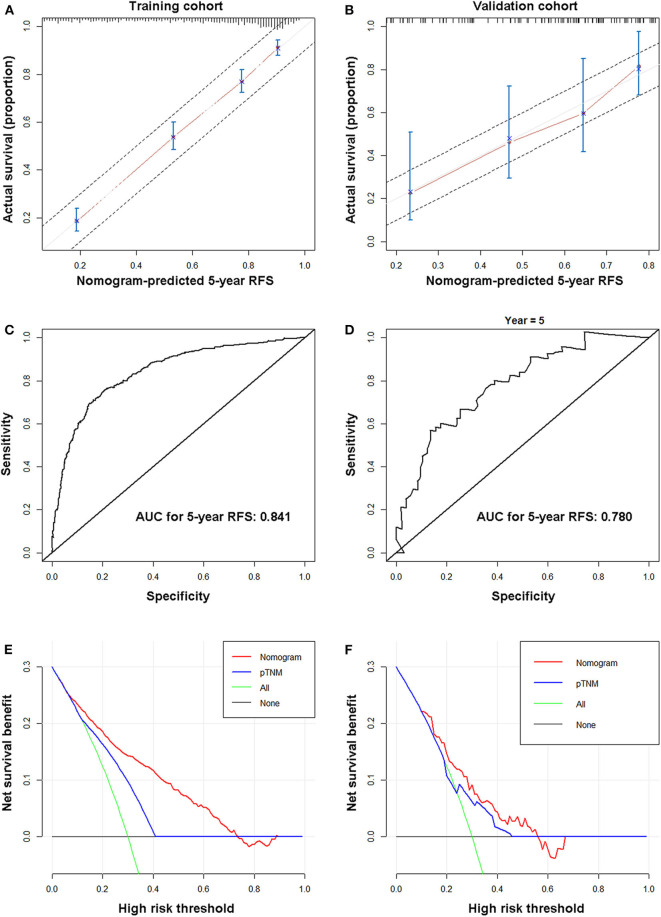
Nomogram properties. Calibration (A,C), ROC curves (B,D), and decision curves (E,F) of the nomogram for the training (A,B,E) and validation cohorts (C,D,F).